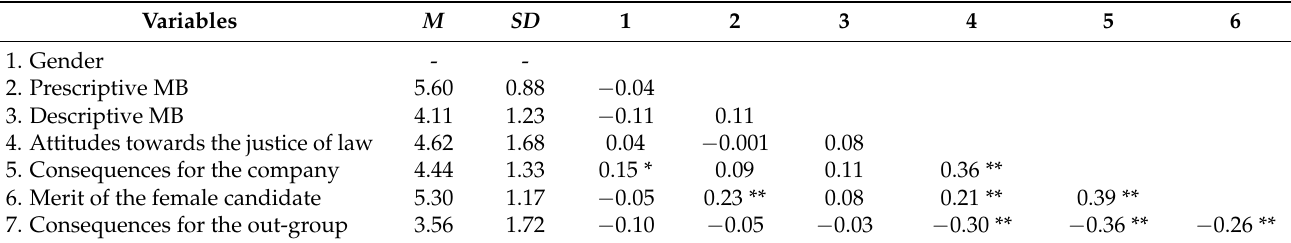
Table 2. Descriptive Statistics and Correlation